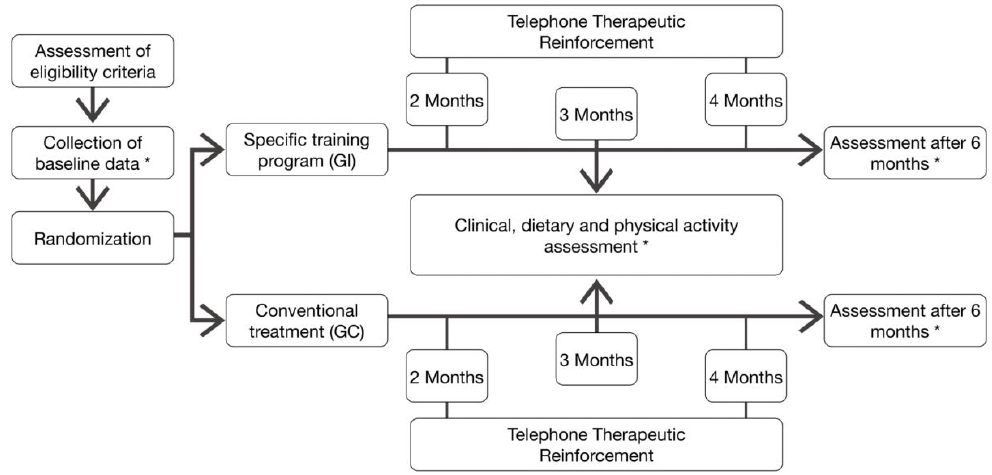
Figure 1. Study Design. * Data collected at baseline and 6 months of intervention: (1) Anthropometric data (Body Mass Index, Neck circumference, Waist-to-hip ratio); (2) Physical activity (steps/day); (3) Questionnaires (Epworth Sleepiness Scale, Functional Outcomes of Sleep Questionnaire]; (4) Sleep-disordered breathing detected through polygraphy (Just for baseline and six months after intervention) (Apneas–Hypopneas Index, SpO2 mean (%), registered time spent with SpO2 < 90% (%) and Oxygen desaturation index); (5) Biochemical parameters (Urea, Creatinine, Alanine aminotransferase, Aspartate aminotransferase, Blood glucose, Total Cholesterol, High-density lipoprotein cholesterol, Low-density lipoprotein cholesterol and